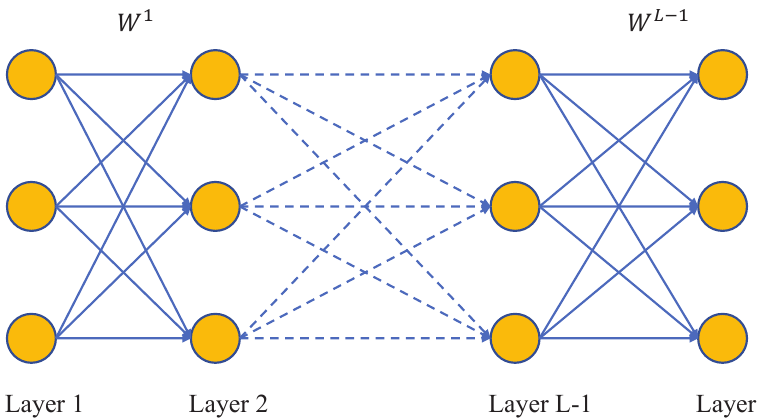
Figure 1. Architecture of a BPNN that contains L layers. Typically, Layer 1 is the input layer, which inputs data into the neural network, and the last layer, Layer L, is the output layer, which outputs the predicted values. The W between every pair of layers is the weight, which is the knowledge of the